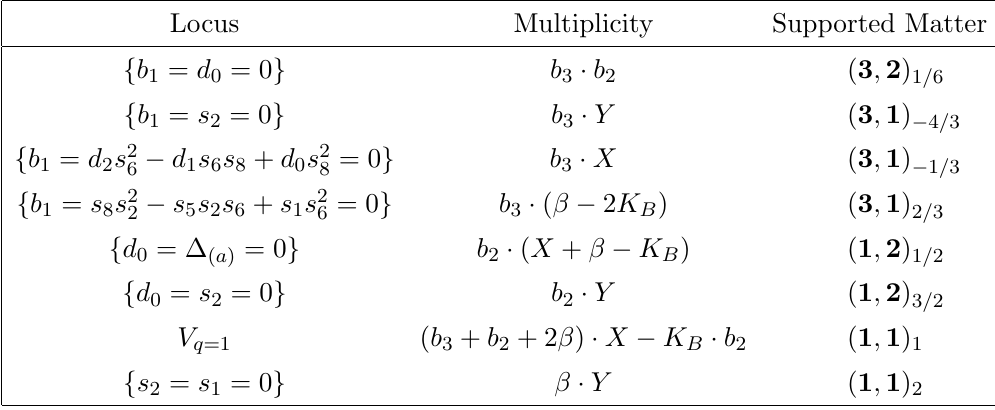
Table 4 . Codimension-two loci of the (SU(3) (cid:2) SU(2) (cid:2) U(1)) = Z 6 model and the associated charged matter. The multiplicities are for a 6D model constructed using the (SU(3) (cid:2) SU(2) (cid:2) U(1)) = Z 6 Weierstrass model (3.1). Note that (cid:1) is de(cid:12)ned in eq. (6.3), while V q =1 is de(cid:12)ned in eq. ( a )